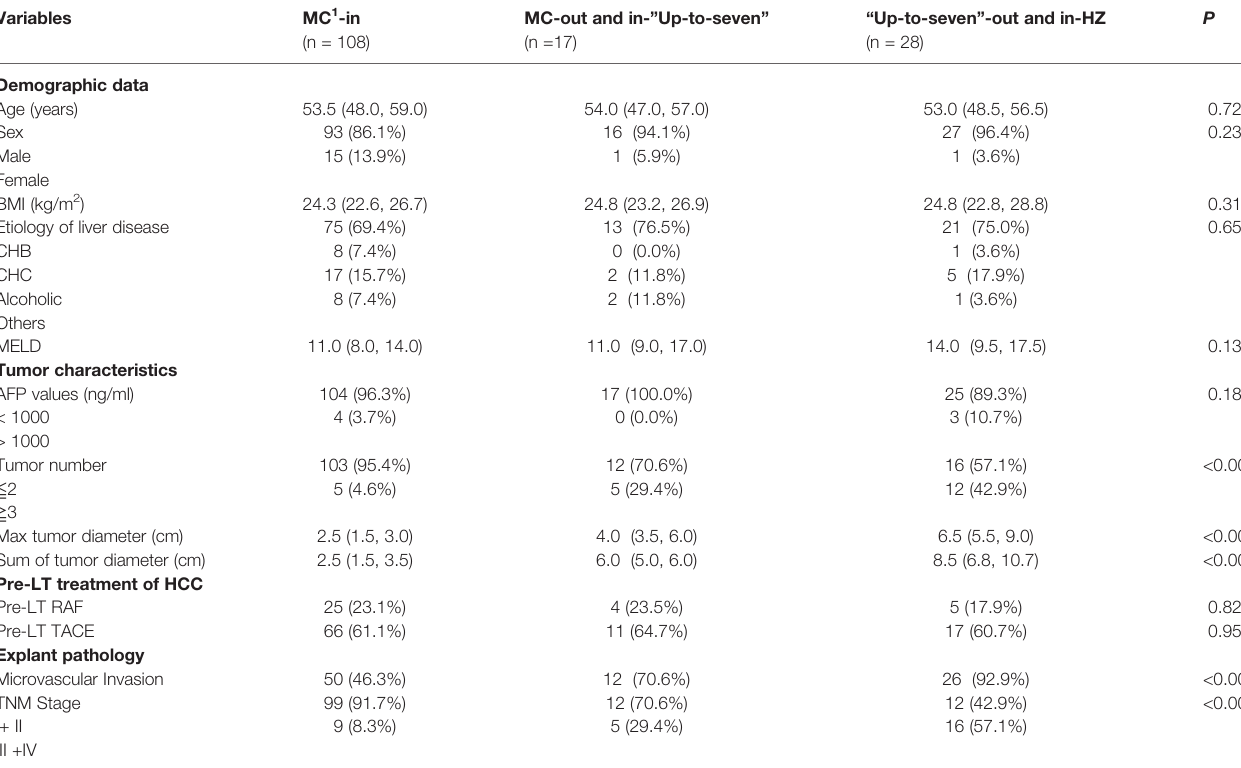
TABLE 4 | Differences of patients with HCC under Milan, “ Up-to seven, ” and Hangzhou criteria.